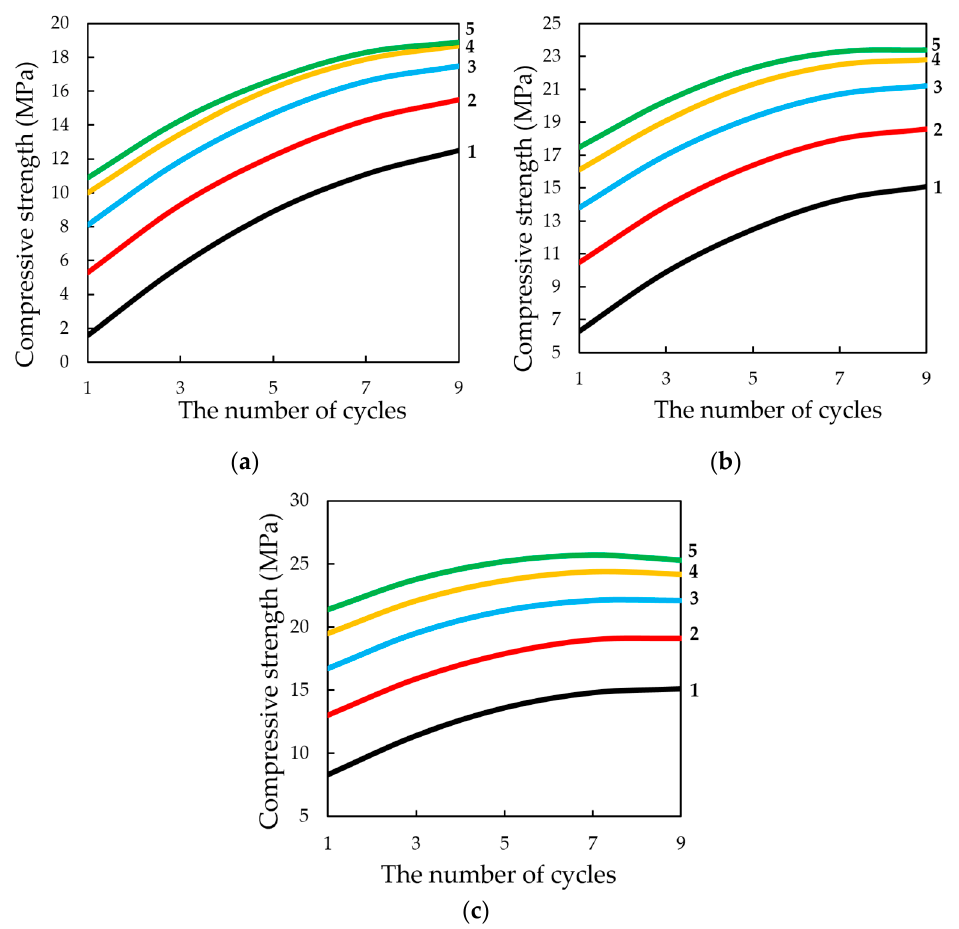
Figure 17. Change in compression strength of testing samples produced by semi-dry pressing at pressing pressure: ( a ) 15; ( b ) 25; ( c ) 35 MPa. Samples carbonated by the dynamic method in gas and air environment with 40% concentration of CO 2 , depending on the number of carbonation cycles and lime content in the raw mix, % wt.: 1 —5; 2 —10; 3 —15; 4 —20; 5 —25.